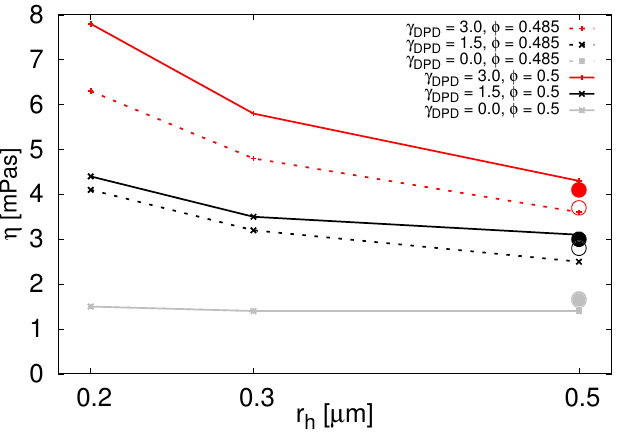
Figure 5. Viscosity for various particle radii and γ DPD (color coded) at φ = 0.5 (solid lines) and φ = 0.485 (dotted lines) in parallel plates computational experiment. For γ DPD = 0 (two gray lines that overlap) we used the soft-sphere interaction between the spherical particles. Data available in Table A5. The circles represent viscosity values from the drag force computational experiment with r h = 0.5 µ m. Solid circles correspond to φ = 0.5 and empty circles to φ = 0.485. Two grey circles almost